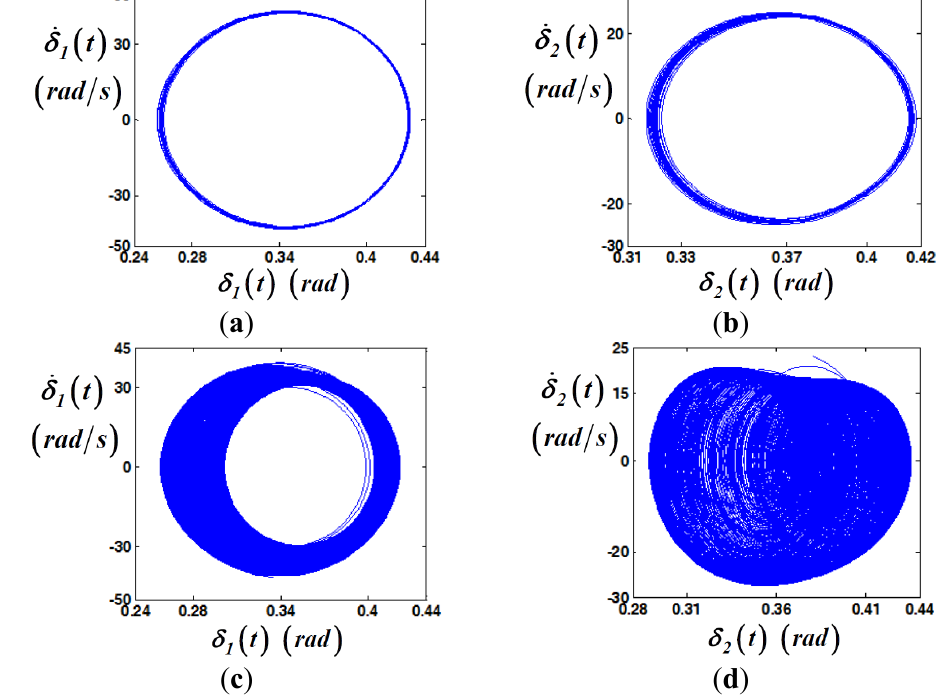
Figure 13. Comparison of phase planes at different excitation conditions: ( a ) phase